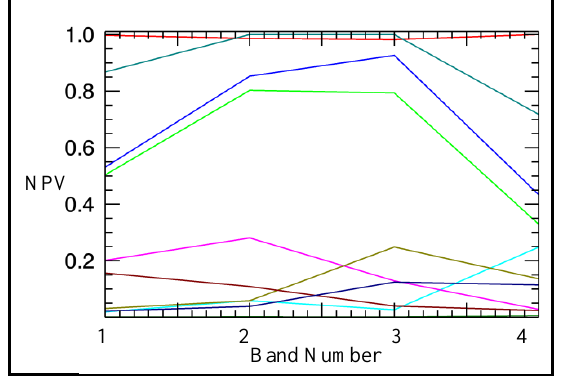
Figure 7. Example of found endmember spectra over the first four bands of the Sentinel-2 data. The spectra represent normalised pixel values (NPV). It can be seen that some are more similar than